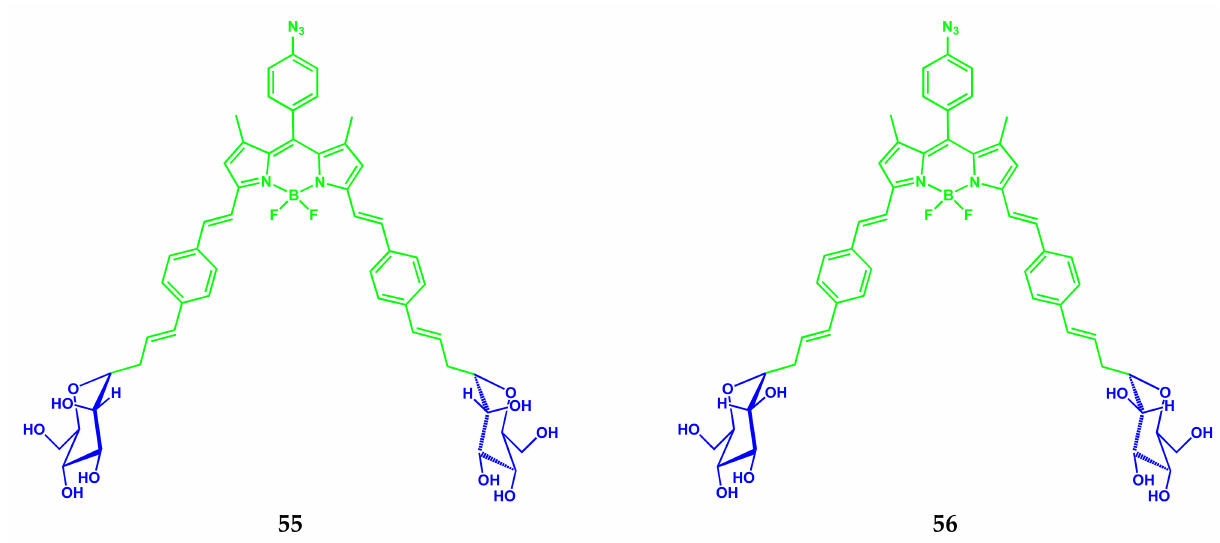
Scheme 32. Structures of compounds 55 and 56